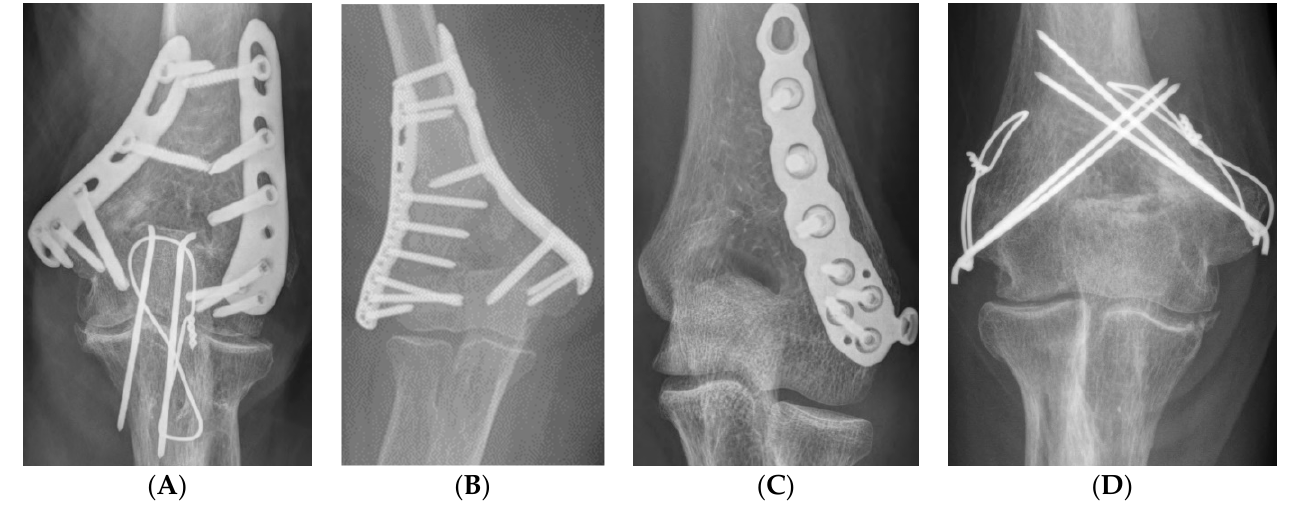
Figure 1. Fixation method ( A ) orthogonal plate, ( B ) parallel plate, ( C ) single plate, ( D ) tension band wiring.